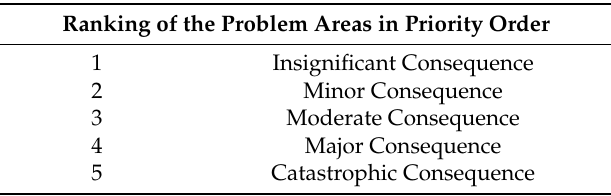
Figure 2. Frame work of the diagnostic tool for non-technical compliance of small water treatment plants developed by Momba and co-workers [1]. Table 1. Ranking of the Problem Areas in Priority Order [1].